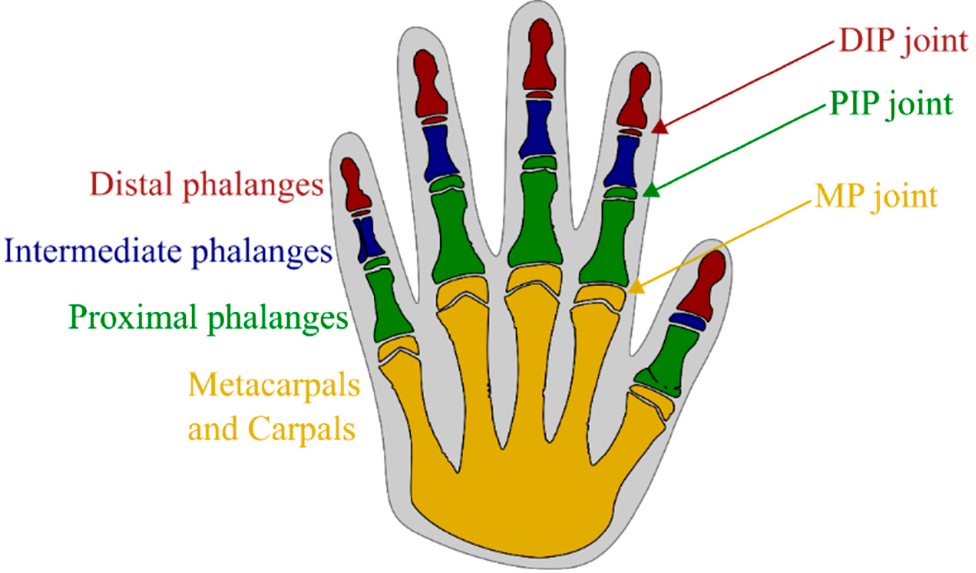
Figure 1. Anatomy of the human hand.